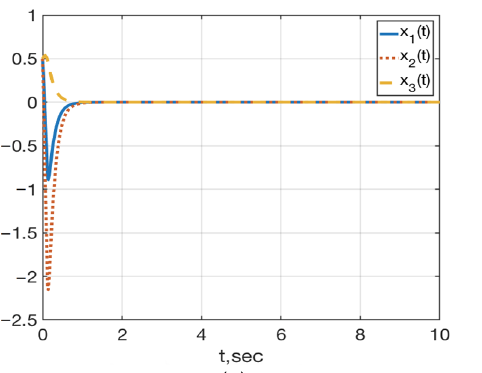
tutu in the closed-loop system Figure 5. ( a ) Plots of x 1 ( t ) , x 2 ( t ) , x 3 ( t ) ; ( b ) Plots of u 1 ( t ) , u 2 ( t ) in the closed-loop system 21